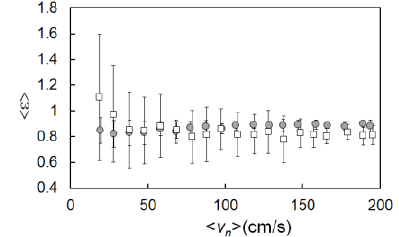
Fig. 3. Mean values <  > and its standard deviations  obtained in windows of width 10cm/s for V n . (Disks with filled circles and faceted particle with empty squares). Magnitudes are plotted vs. mean values < V n > obtained in the mentioned